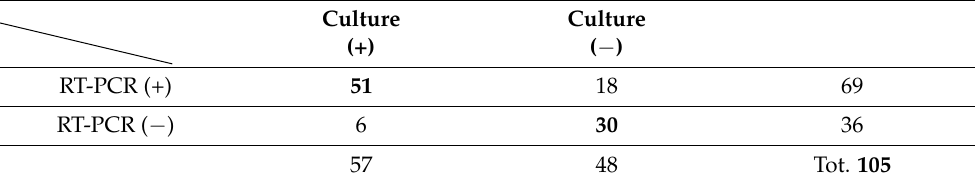
Table 1. Presence/absence of P. larvae according to molecular and microbiological analyses of 105 powdered sugar samples.